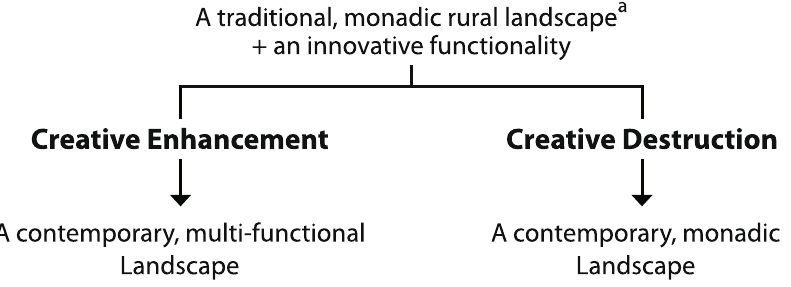
Fig. 1 Processes of change in a rural space (Source: adapted from Mitchell